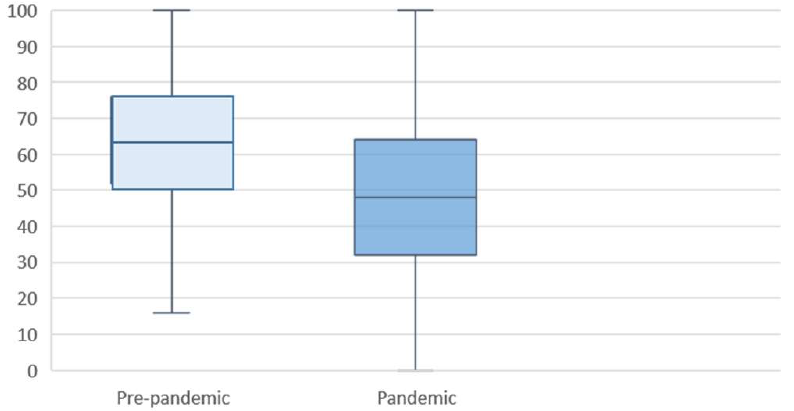
Figure A1. WHO-5 well-being level in pre-pandemic ( n = 345) and pandemic ( n = 1320) cohorts.